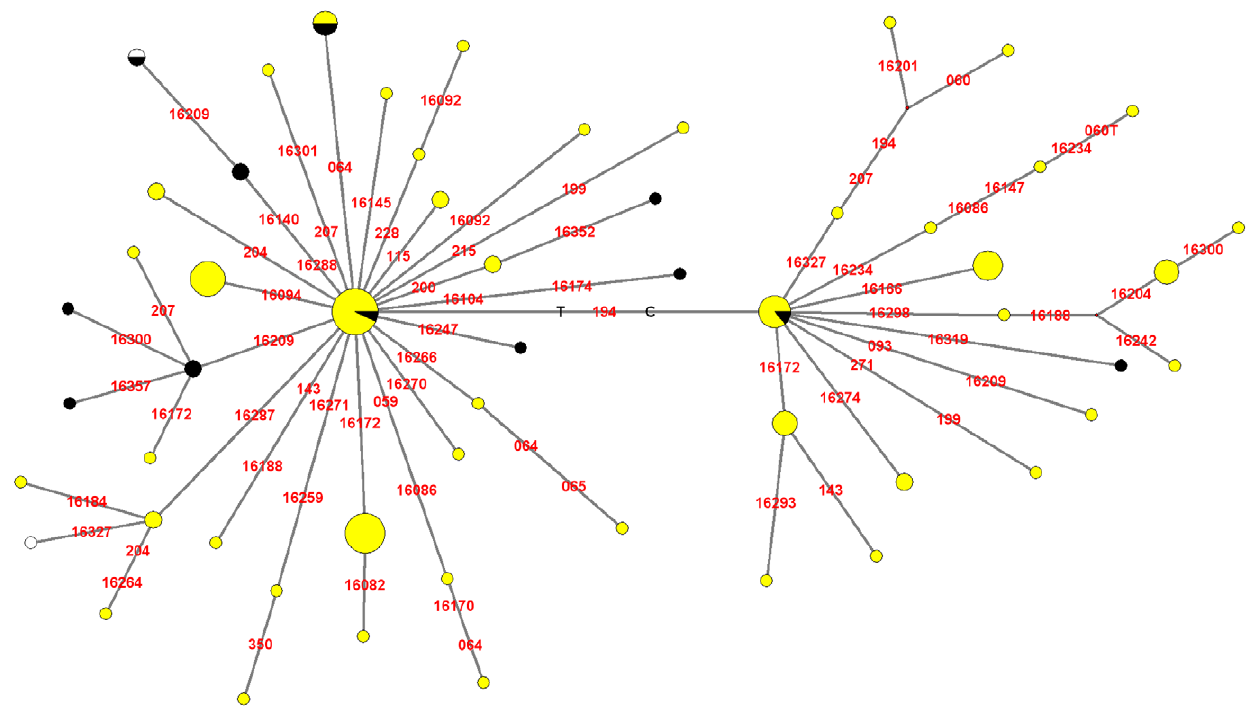
Figure 3. Median-Joining Network generated from the compiled HVR-I and HVR-II sequences. Yellow: fraction of the lineage carrying the 7697G R A mutation. Black: fraction of the lineage carrying the ancestral 7697G allele. White: fraction of the lineage lacking data on the state of np